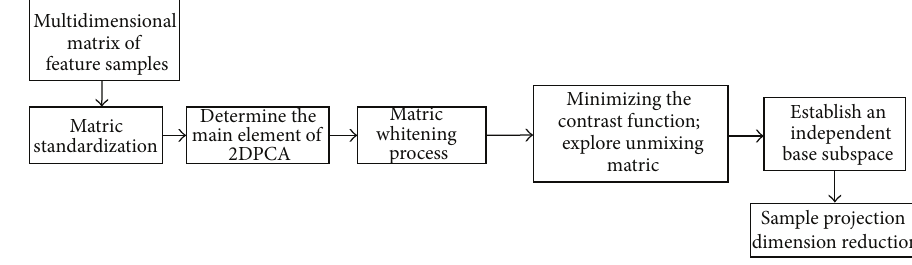
Figure 1: The flowchart of multidimensional characteristic parameter optimization.